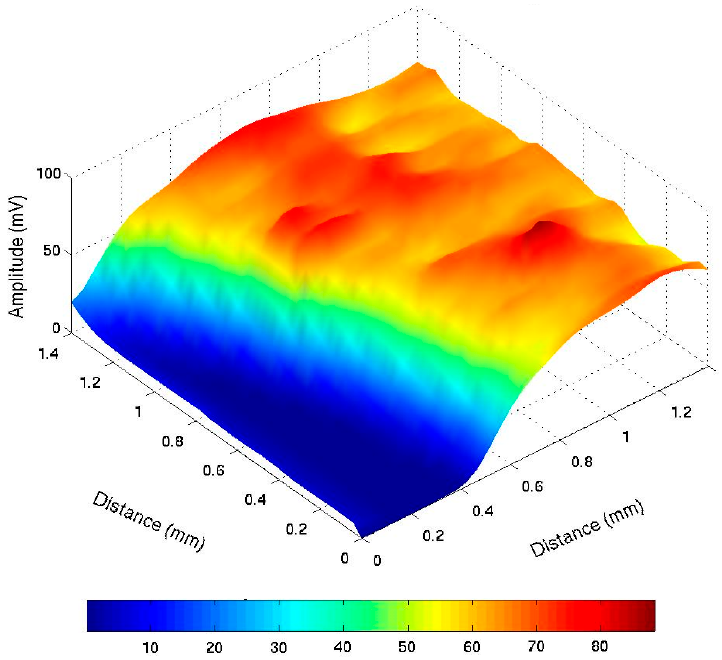
Figure 1. PTR amplitude response from steel 1018 at 10 Hz–1 KHz.